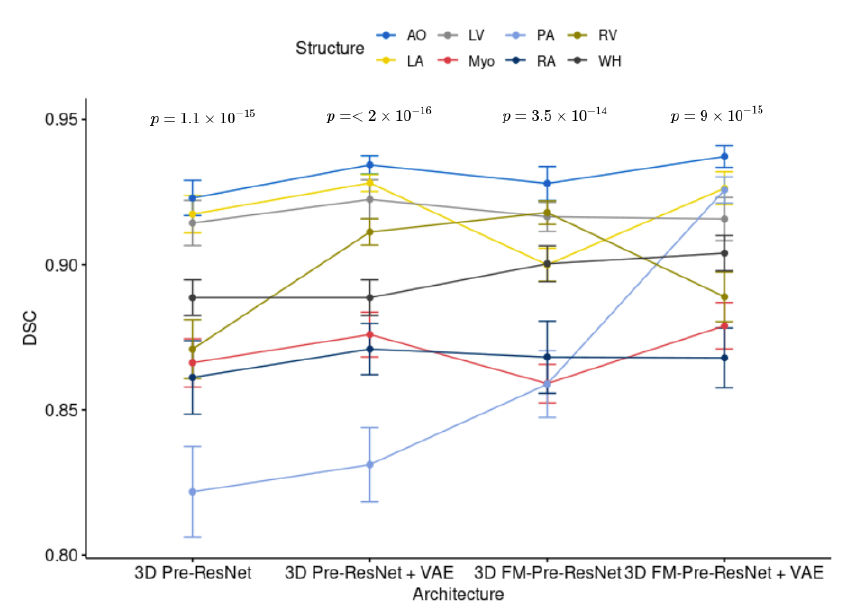
Figure 8. Comparison of Wilcoxon rank sum test of each heart structure for different architectures on the MMWHS CT testing dataset.